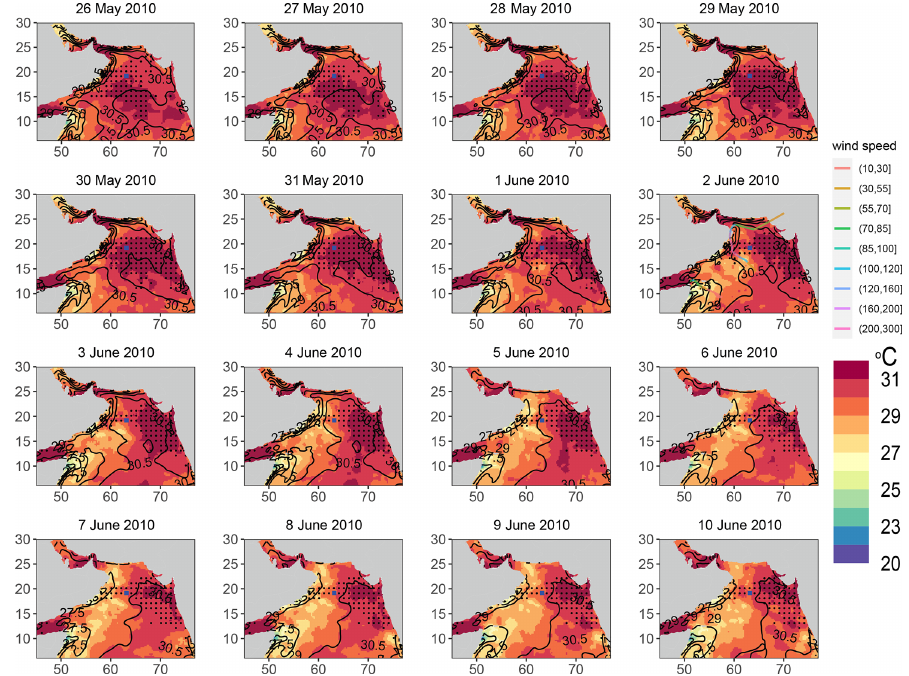
Figure 9. Same as Fig. 8 but plotted daily to show the decaying phase of the heatwave event. The coloured curve on the panel for 2 June 2010 represents track (and wind speed) of the tropical cyclone